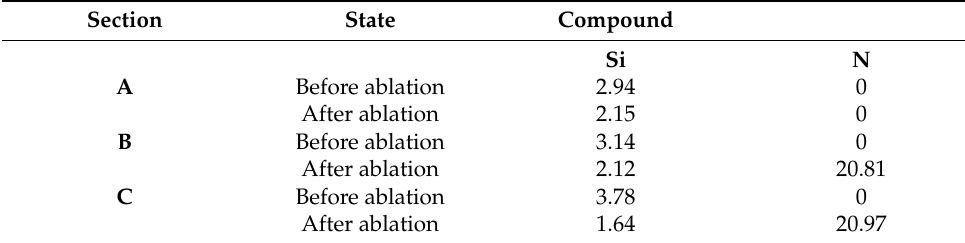
Table 5. Comparison of the elements in each section of the the transverse sections